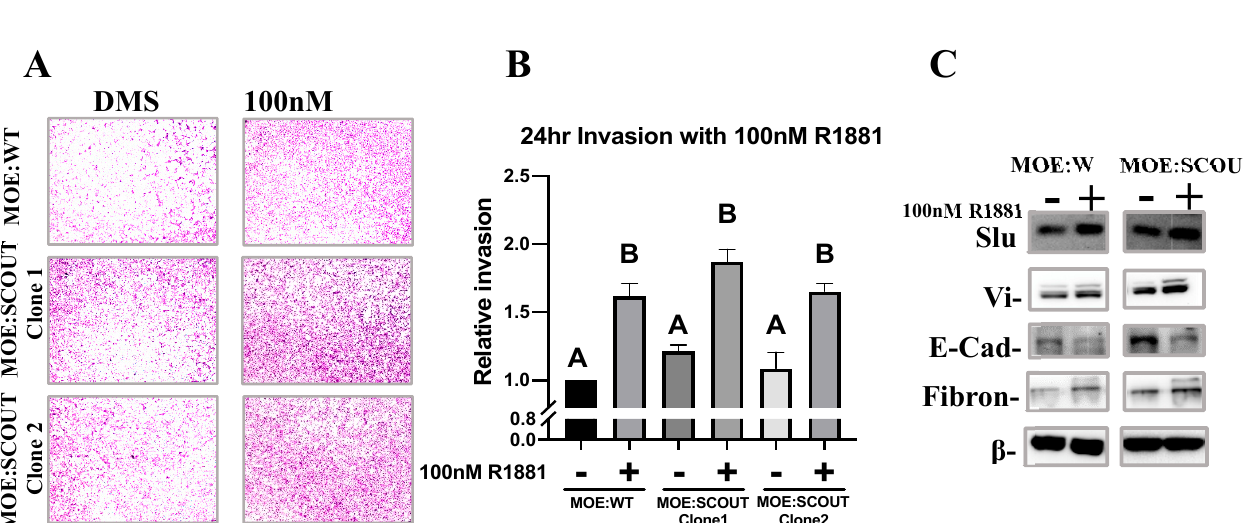
Figure 4. Androgen increases in vitro invasion of murine oviductal epithelial cells. ( A , B ) Cellular invasion was measured by Boyden chamber assay. MOE:WT or MOE:SCOUT cells were seeded in steroid free media on Matrigel coated transwells and allowed to invade toward steroid free media supplemented with either DMSO or 100 nM R1881 for 24 h. ( n ≥ 3, one-way ANOVA followed by a Tukey’s post-hoc, letters above bars indicate differences between groups at p < 0.05). ( C ) Western blot analysis of markers associated with invasion. Cells were cultured in steroid free media for 24 h followed by exposure to either DMSO or 100 nM R1881 for 24 h.